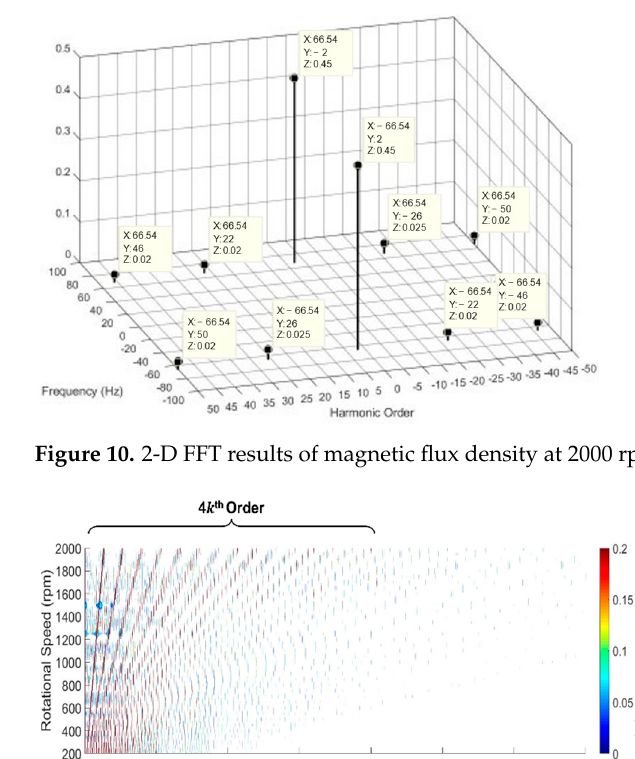
Figure 9. Distribution of magnetic flux density at 2000 rpm. ( a ) 3-D distribution of magnetic flux density. ( b ) 2-D distribution of magnetic flux density.